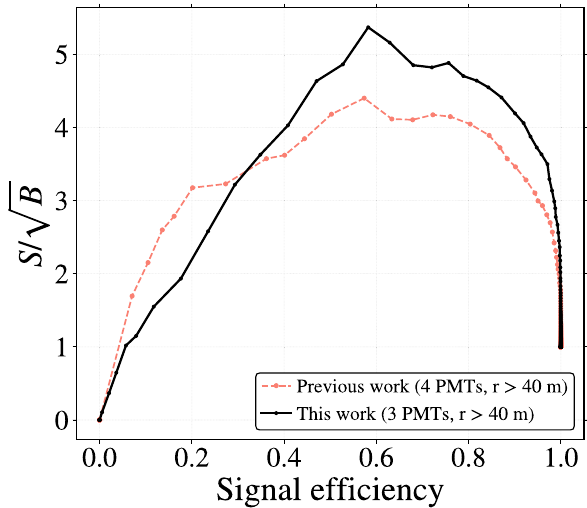
Fig. 8 P γ h distributions for proton (black line) and gamma (red line) Fig. 9 Ratio of the selection efficiency for gammas ( S ) over the square